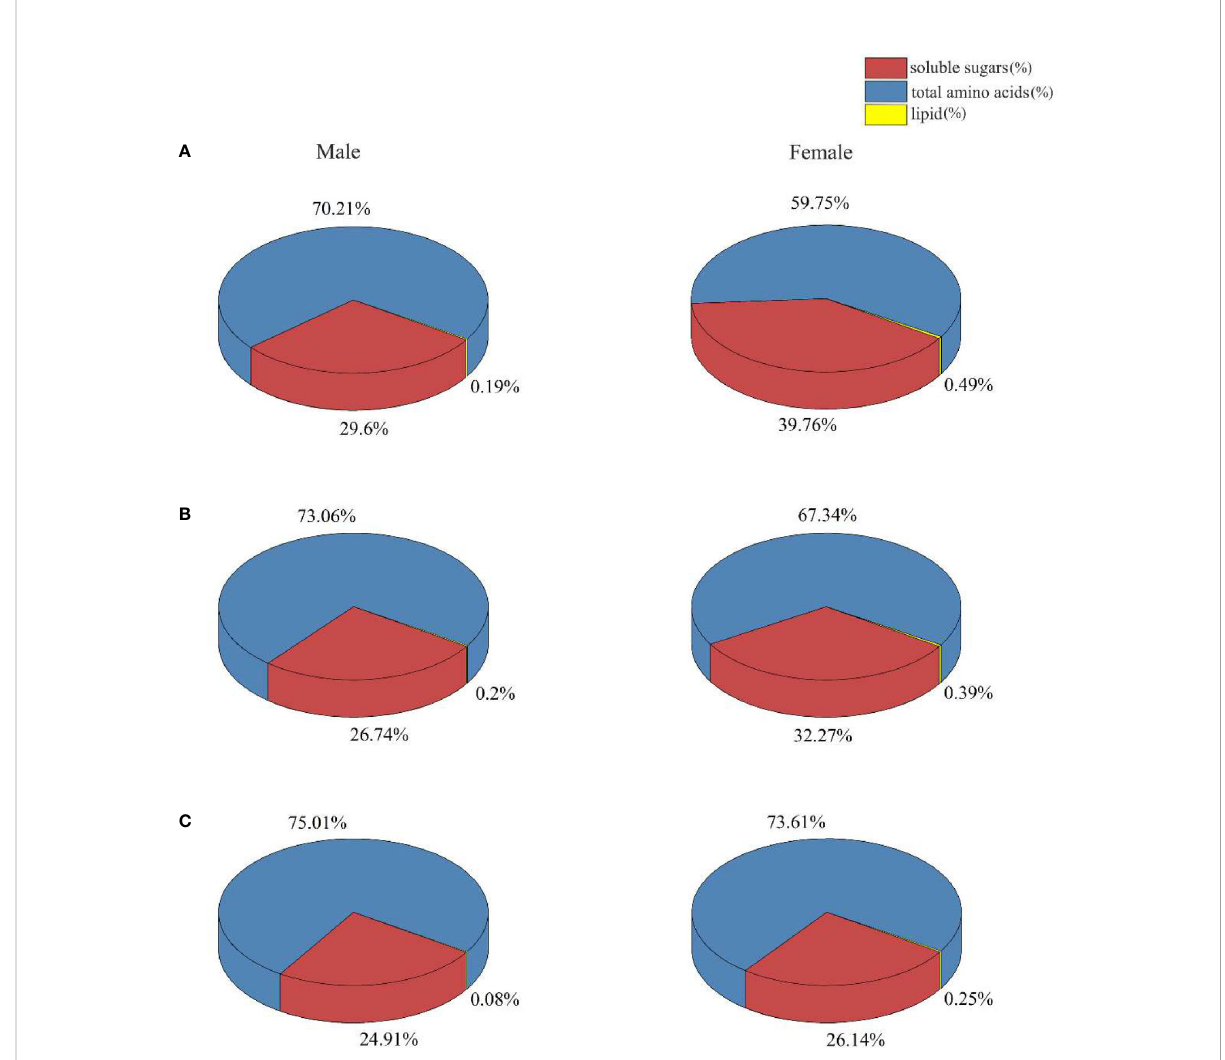
FIGURE 6 The proportion of soluble sugars, lipids, and amino acids in male and female S. thunbergii under different conditions (A) control group; (B) low UV-B radiation; (C) high UV-B radiation.